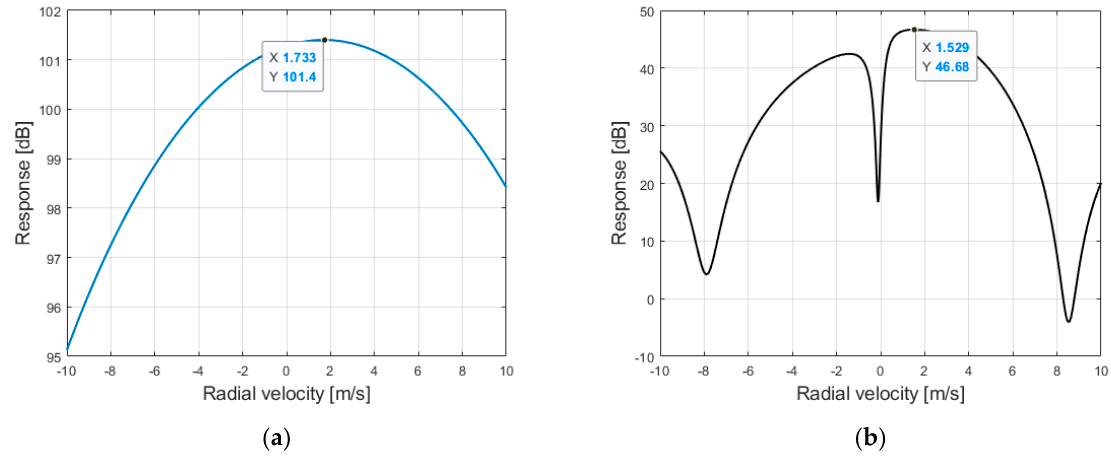
Figure 11. Range − Doppler image of the moving target detection: ( a ) amplitude detector; ( b ) phase detector with amplitude assistance.